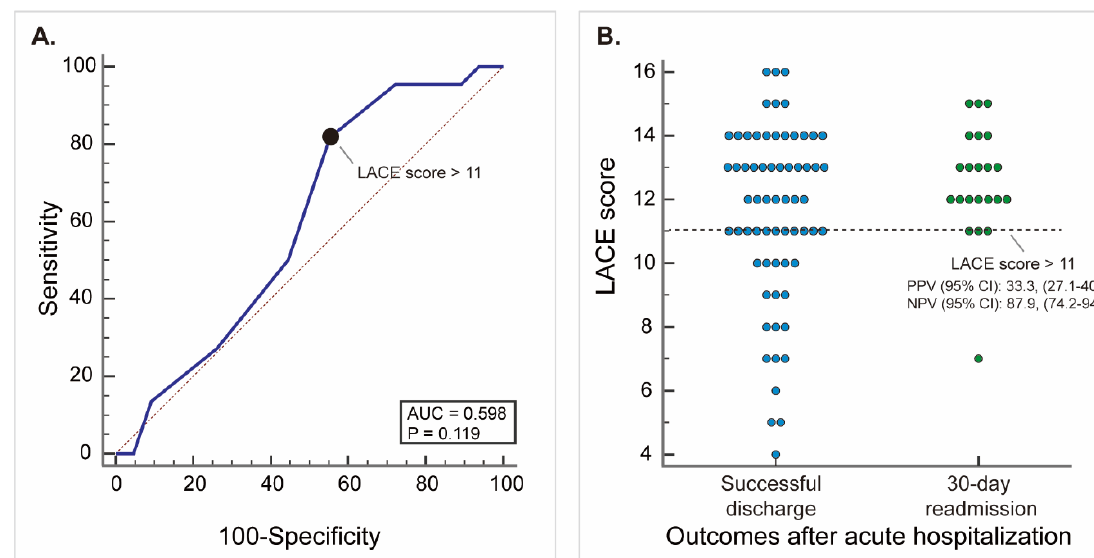
Figure 2. ( A ) Receiver operator characteristic (ROC) curve of validating LACE score for readmission in the Pre-Implement cohort in the long-term home care unit in 2017 ( n = 87, 2017). The cut-off value based on the Youden index is also shown as the solid black circle in the chart. ( B ) Distribution of LACE score for readmission in patients with successful discharge and 30-day readmission. Each dot represents one patient with its color denotes a different outcome. The horizontal line in the chart shows the cut-off value based on the Youden index. (The Pre-management cohort in 2017, n = 87).